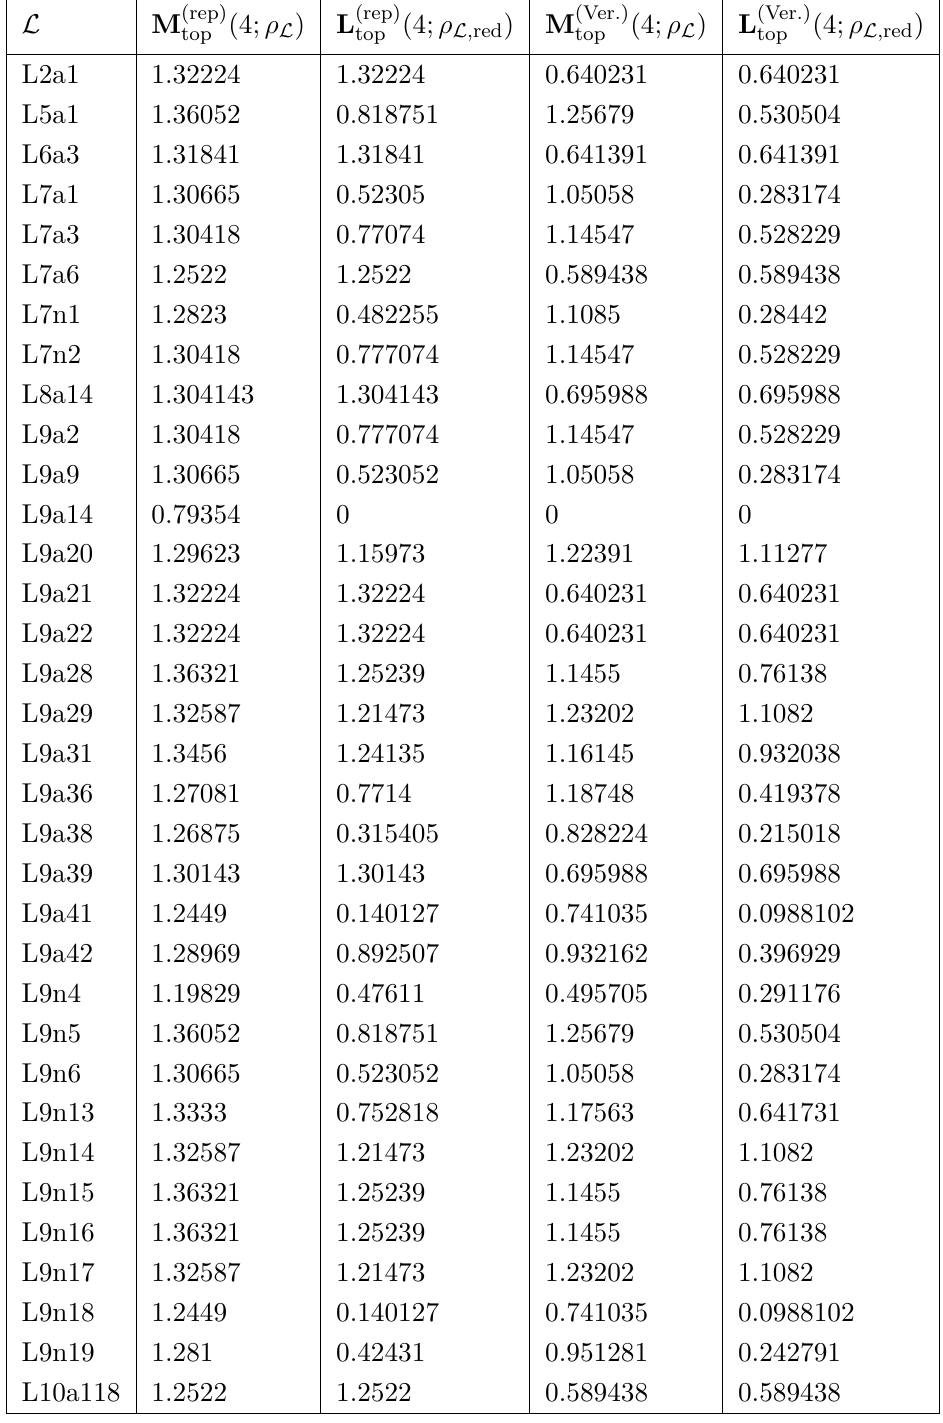
Table 2 . The k = 4 topological global mana and the topological long-range mana for a set of two-links in both the rep and Verlinde bases